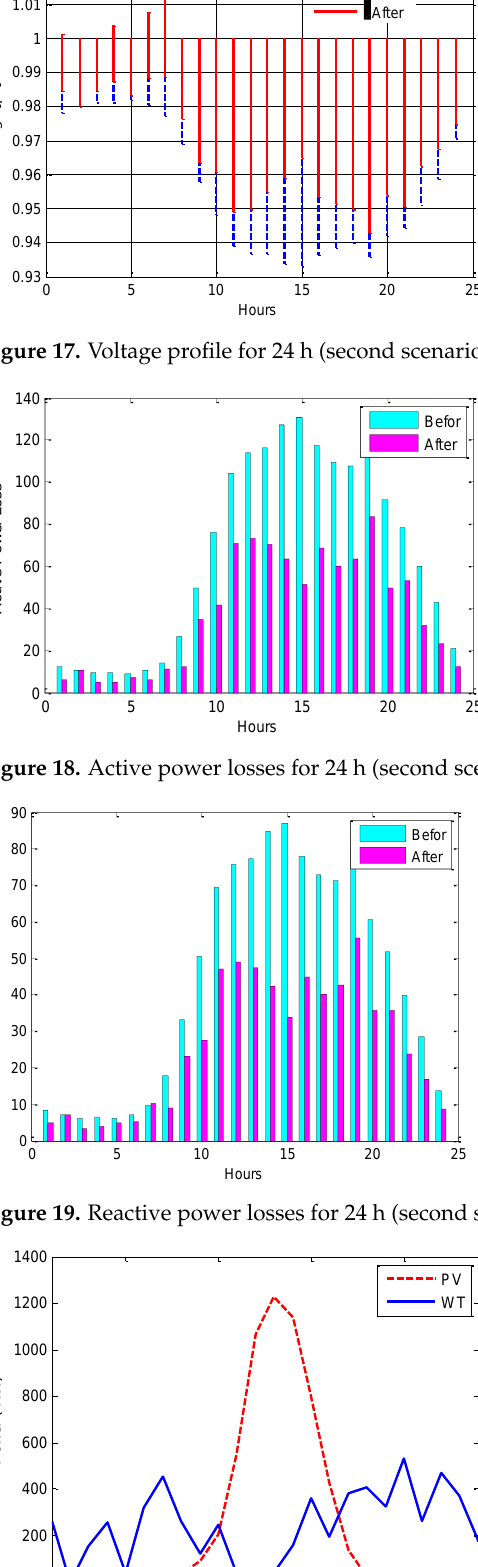
Figure 20. Power produced by RES for 24 h (second scenario).